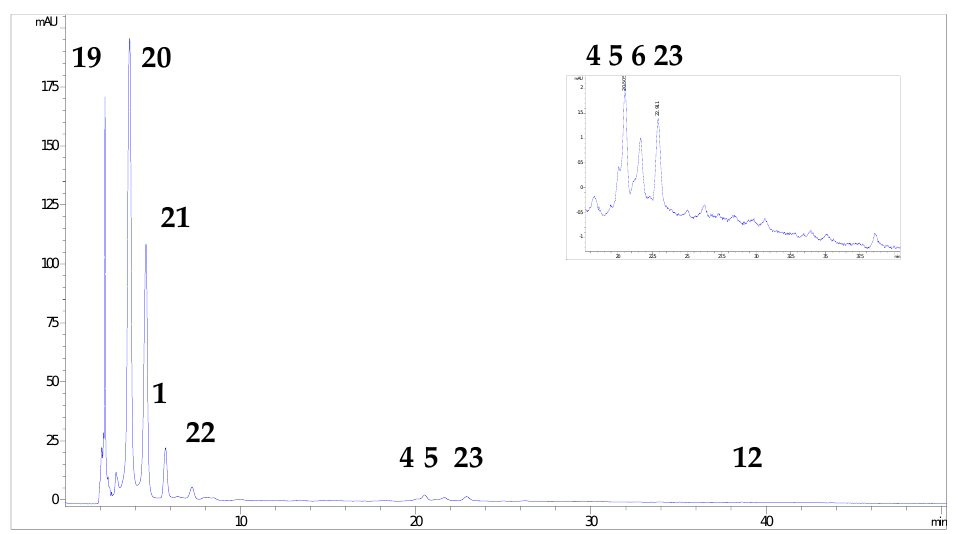
Figure 5. HPLC chromatograms of investigated black mulberry fruit ethanol extract and phenolic compounds identified (the numbers refer to corresponding peaks, presented in Table 1): procyanidin B1 (19), protocatechuic acid (20), p-hydroxybenzoic acid (21), chlorogenic acid (1), epicatechin (22), rutin (4), hyperoside (5), isoquercetin (6), protocatechuic acid ethyl ester (23) and quercetin (12).